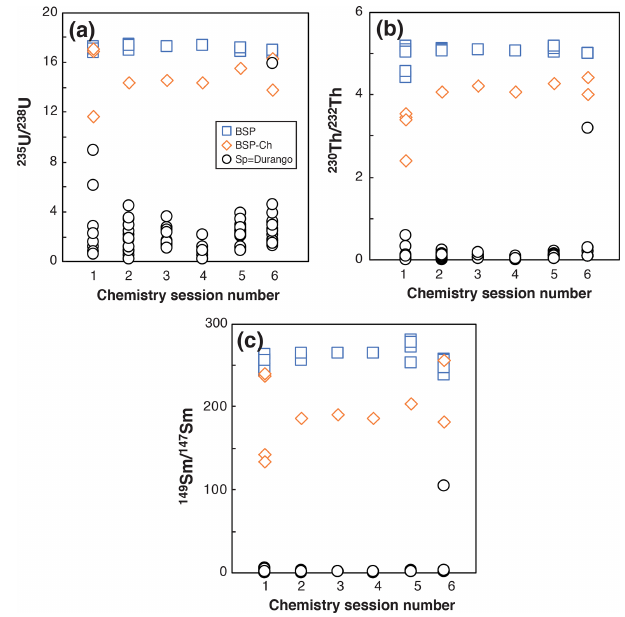
Figure 6. Evolution of the 235 U / 238 U, 230 Th / 232 Th, and 149 Sm / 147 Sm ratios obtained for BSP, BSP-ch, and Durango ap- atite Sp solutions in six different chemistry